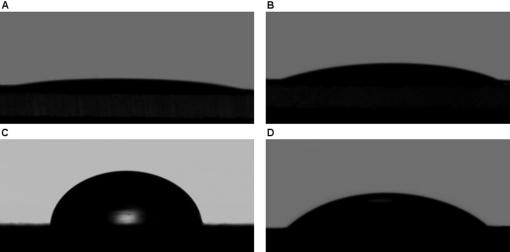
Photographs of water drops on the various surfaces used in the determination of the water contact angles: (a) mica; (b) EAK16-II-modified mica; (c) HOPG; (d) EAK16-II-modified HOPG.